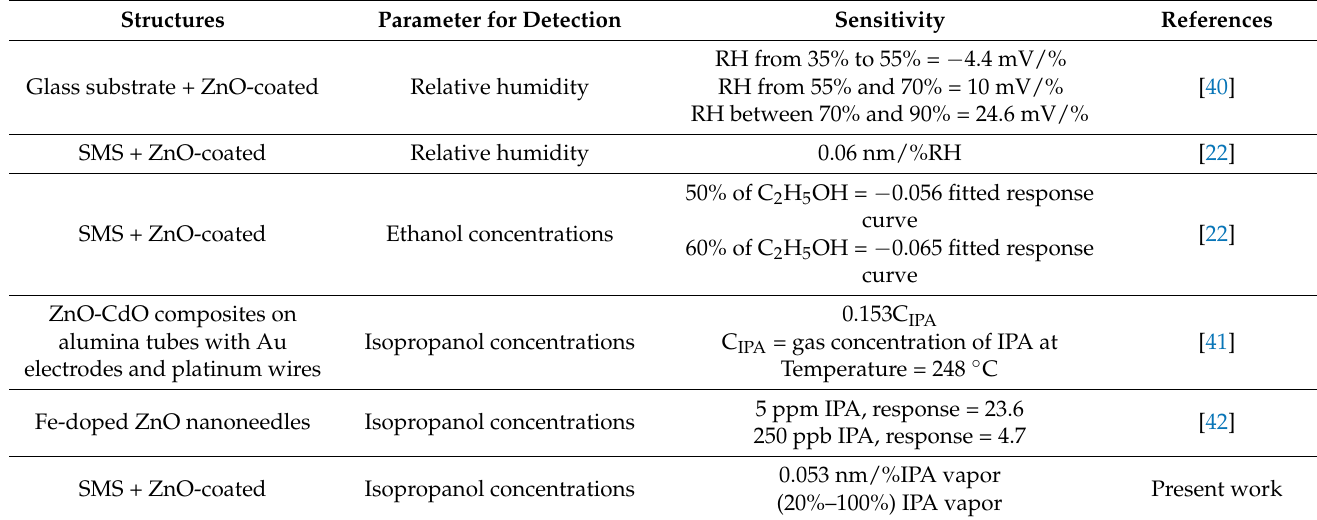
Table 1. Comparison of ZnO nanostructures coated on different substrates for alcohol sensing. Structures Parameter for Detection